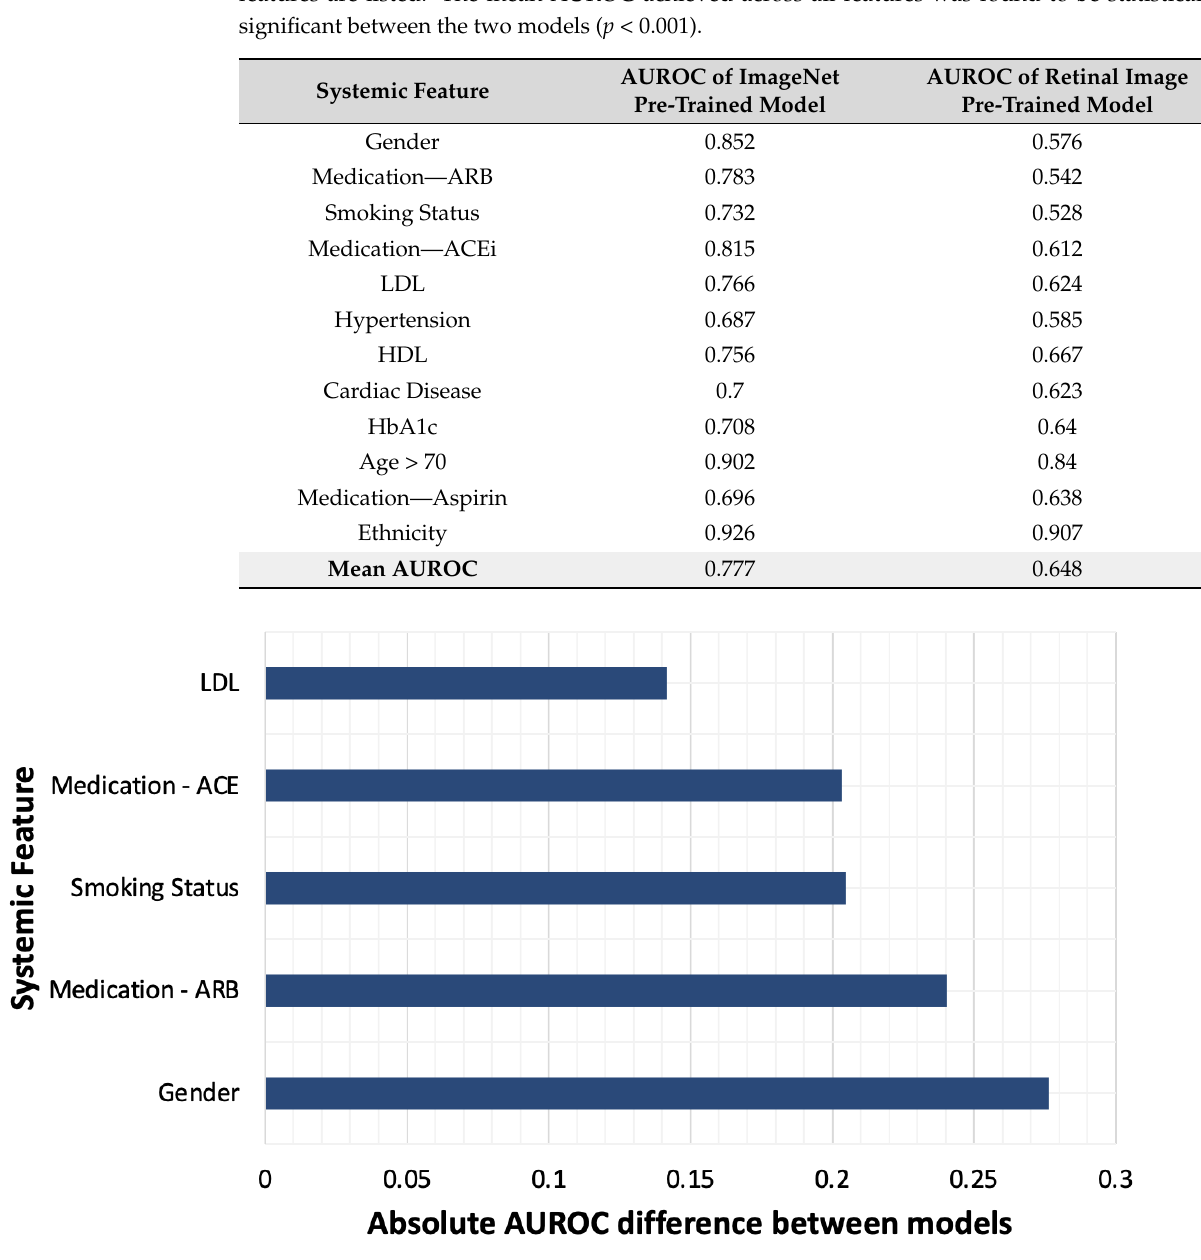
Figure 5. Five systemic health features for which the classification accuracy differed the most between the two AI models based on AUROC. Table 3. Comparing ImageNet pretrained and retinal image pretrained model performances. The achieved area under the receiver operating characteristic curve (AUROC) for each of the 12 systemic features are listed. The mean AUROC achieved across all features was found to be statistically sig- nificant between the two models ( p < 0.001).